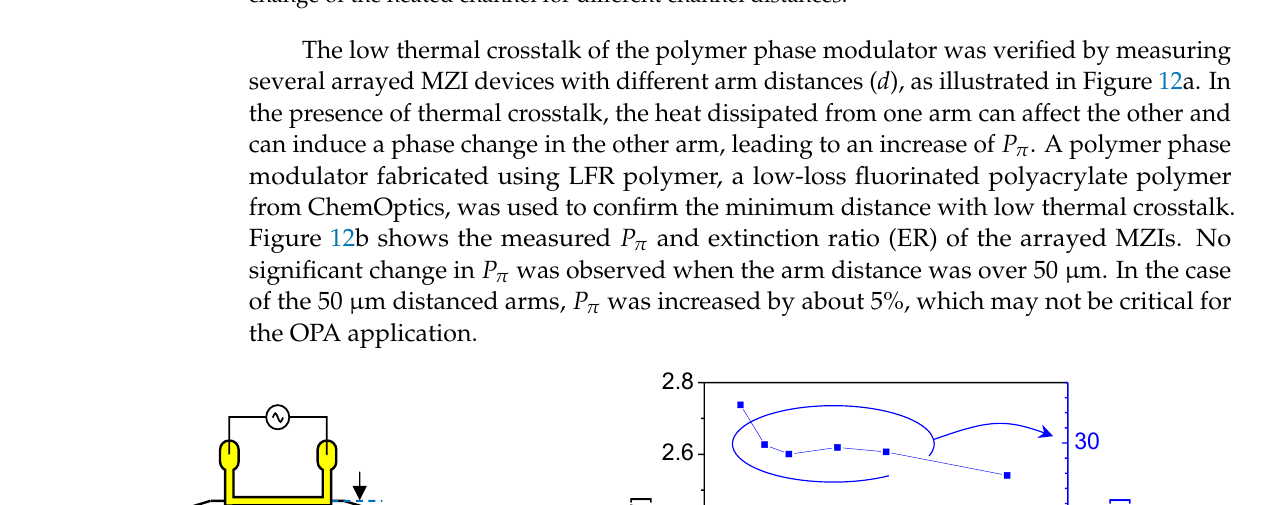
Figure 11. ( a ) Heat distribution around the heater and the waveguide channels when the channel distance was 100 μ m. ( b ) Temperature change in the adjacent channel core compared to the temperature change of the heated channel for different channel distances.